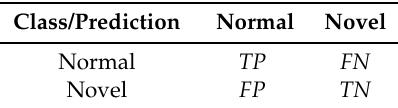
Table 4. TP represents the number of true positives (normal data labeled as normal), TN represents the number of true negatives (novel data labeled as novel), FP represents the number of false positives (novel data labeled as normal), and FN represents the number of false negatives (normal data labeled as novel). Table 4. Confusion matrix to evaluate the performance of the novelty detectors. FN : false negative; FP : false positive; TN : true negative; TP : true